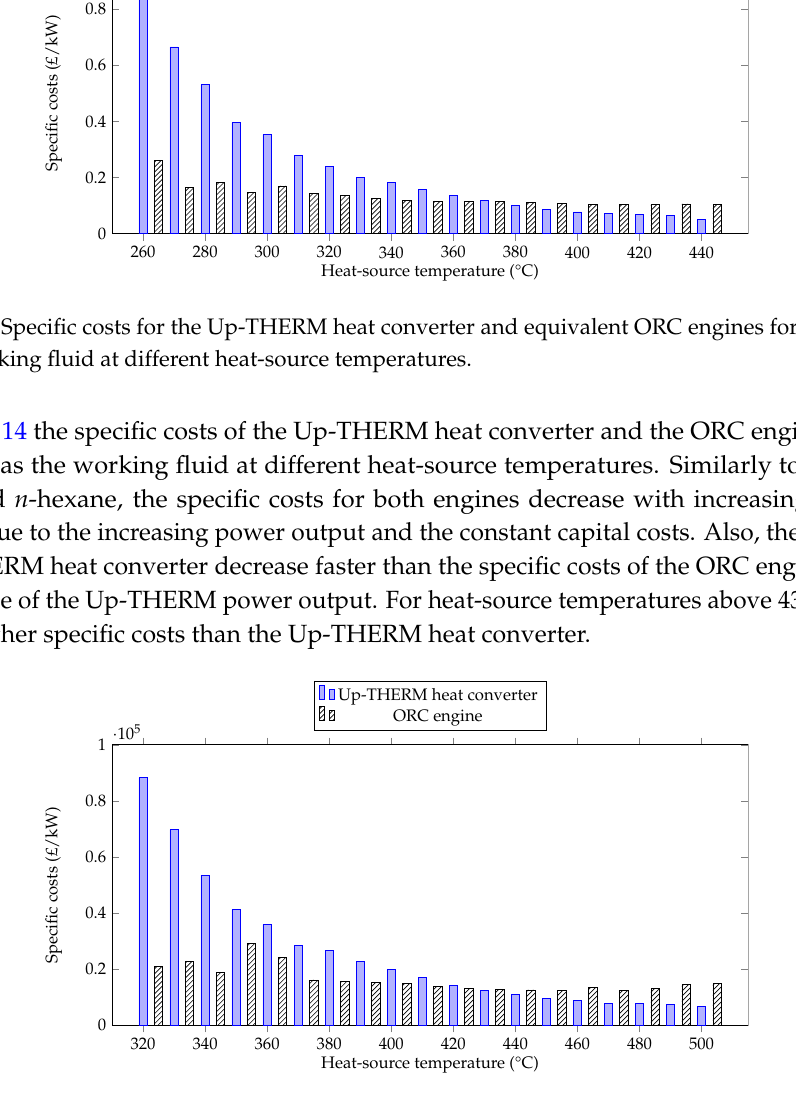
Figure 14. Specific costs for the Up-THERM heat converter and equivalent ORC engines for n -heptane as working fluid at different heat-source